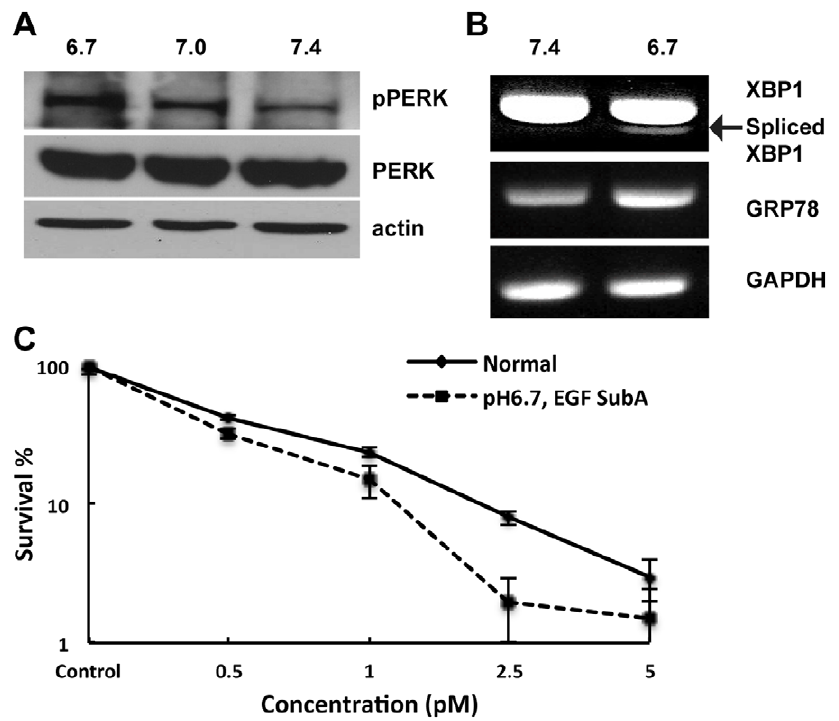
Figure 5. Acidic pH activates the UPR pathway and enhances EGF-SubA cytotoxicity. U251 cells grown in RPMI media whose pH was adjusted to 6.7 and 7.0 with 1N HCl for 3 passages prior to performing experiments demonstrated UPR activation, as determined by PERK phosphorylation (A; pPERK), Xbp1 splicing and increased GRP78 transcription (B). (C) To determine if cells grown in acidic conditions influenced EGF- SubA cytotoxicity, a clonogenic assay was performed with U251 cells grown in normal (pH 7.4) or acidic (pH 6.7) conditions at the stated concentrations. Cell survival was significantly different between cells grown in normal and acidic pH at higher doses of EGF SubA (p , 0.0001 at 2.5 pM). Each figure is a representative of three independent